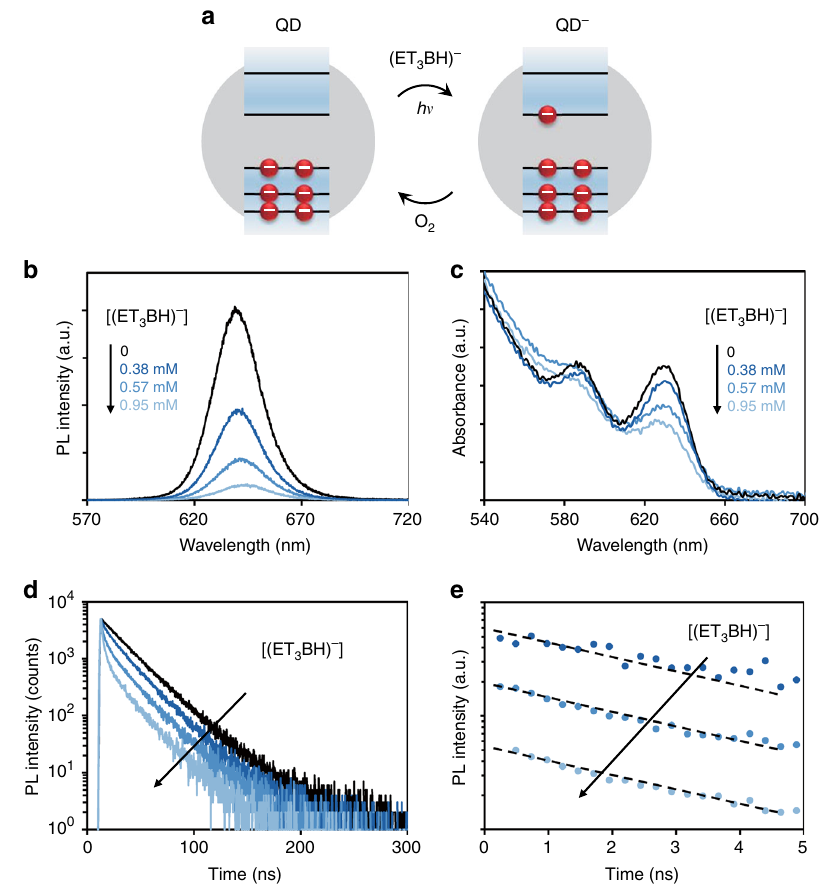
Fig. 2 Photochemical electron-doping of CdSe/CdS core/shell quantum dots (QDs). a Schematic illustration of photochemical electron-doping and re- oxidizing processes. b – d Photoluminescence (PL) spectra, absorption spectra and PL decay curves of neutral (black) and negatively charged CdSe 590 /8CdS core/shell QDs at various stages of photochemical doping (different shades of blue). e The extracted negative-trion decay dynamics at various stages of photochemical doping by subtraction of tail-normalized PL decay dynamics of neutral QDs from that of the negatively charged QDs. The black dashed lines are the mono-exponential fi tting of the extracted decay dynamics